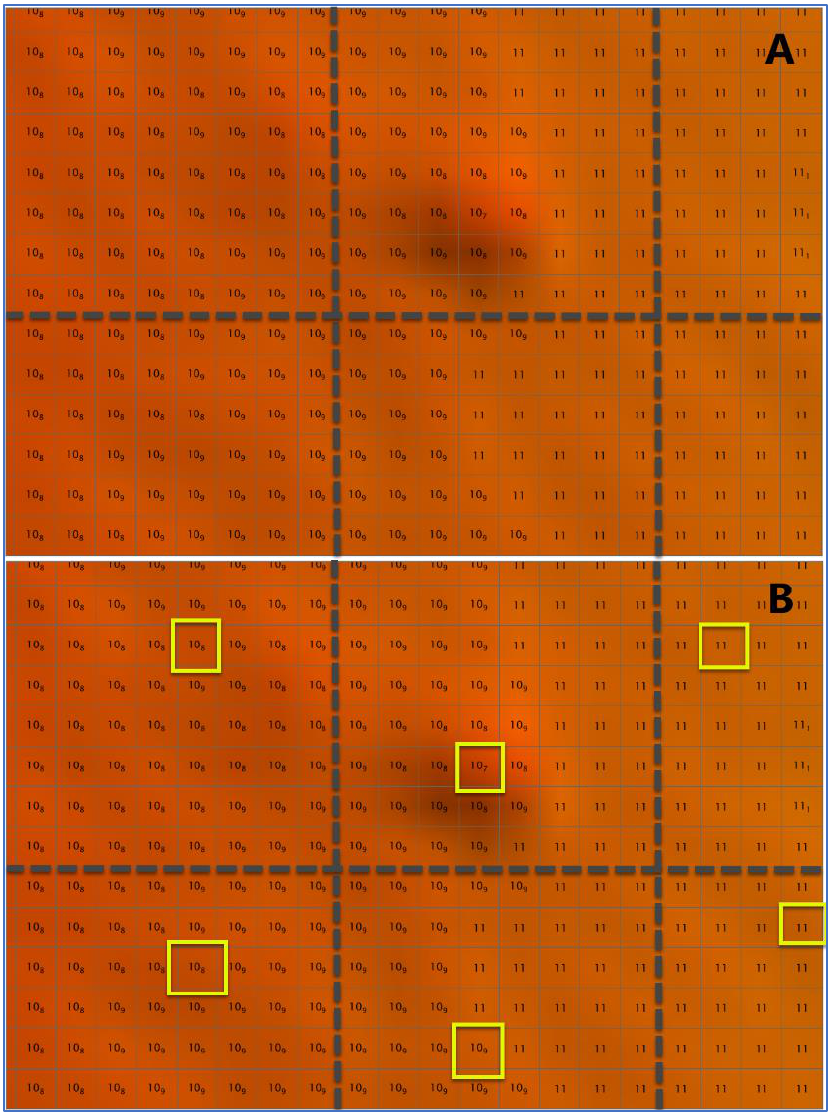
Figure 16. The Moving Window method used in the Sounding Selection tool. First, the area is divided into square window ( A ). The shallowest sounding is then chosen for each area ( B ). The black values are depth values, in meters, from the evaluated grid; when shown, the sub-index represents